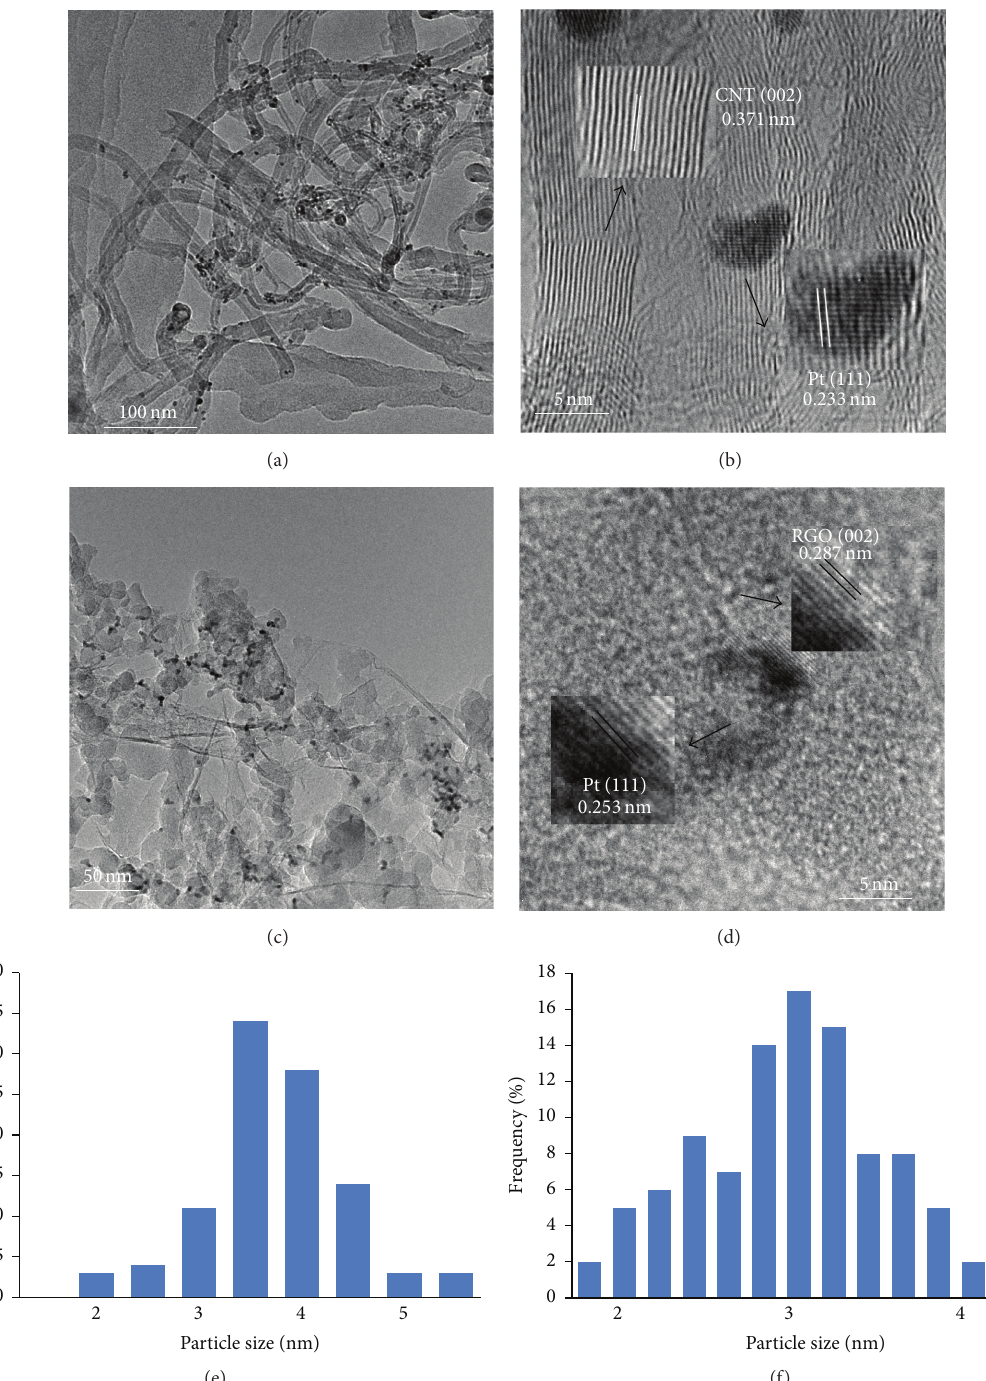
Figure 3: TEM images of (a, b) 3.5 wt% Pt/CNTs and (c, d) 3.5 wt% Pt/RGO@SiO 2 catalysts; Pt particle size distributions of (e) 3.5 wt% Pt/CNTs and (f) 3.5 wt% Pt/RGO@SiO 2 ; the insets in panel (b and d) are the corresponding HRTEM images of CNT, Pt nanoparticle, and reduced graphene oxides